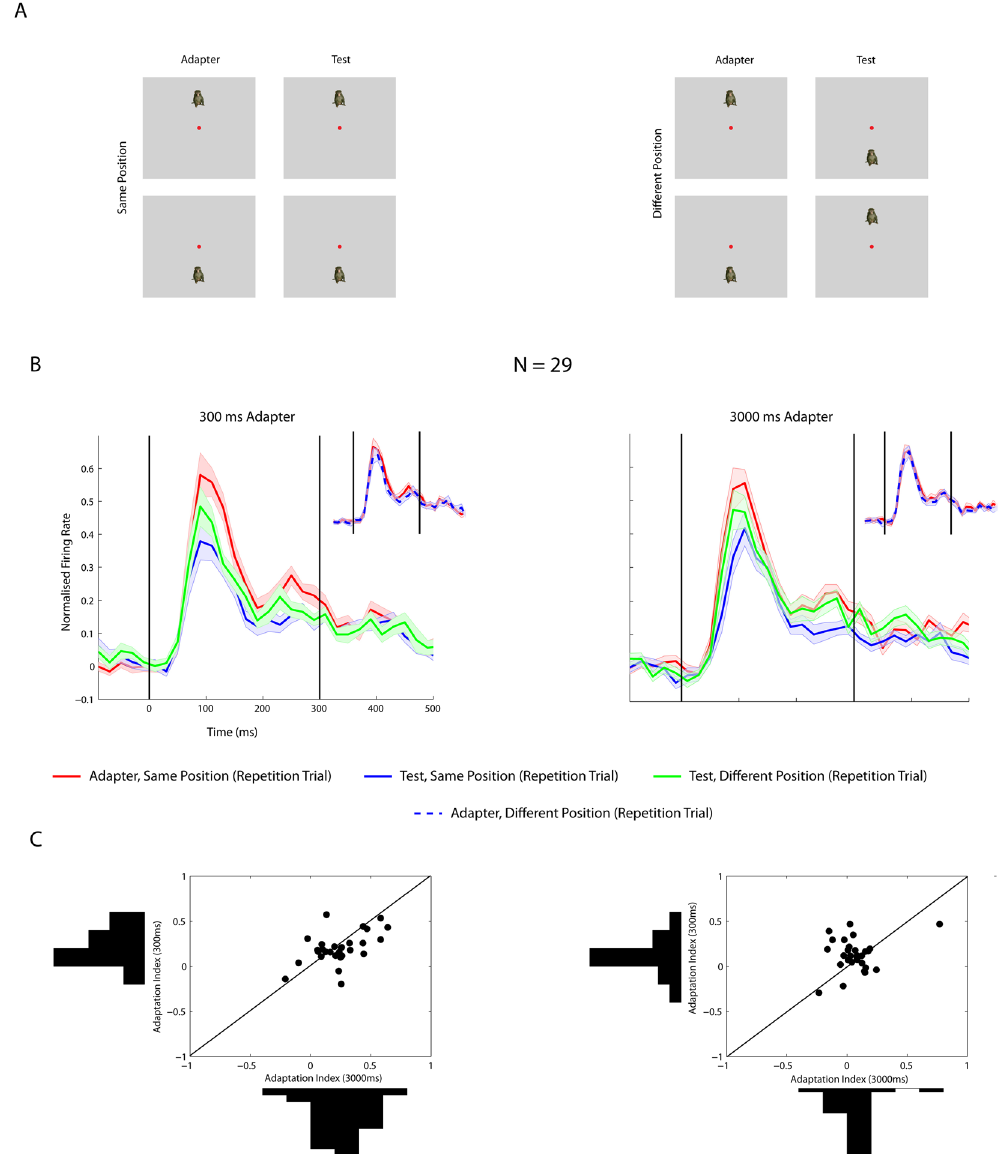
Figure 4. Repetition suppression when adapter and test stimuli were presented at the same or a different position. ( A ) Illustration of stimulus conditions. Adapter and test stimuli were presented at the same (left) or different positions above or below the fixation target along the vertical meridian. ( B ) Normalized firing rate of single IT units to adapter and test stimuli when the adapter and test stimuli were presented at the same position or at a different position during repetition trials. Left: adapter duration equaled 300 ms; right: adapter duration equaled 3000 ms. The insets compare the firing rates to the same adapter stimuli when followed by a test stimulus at the same or a different position. Same conventions as in Fig. 2. ( C ) Scatter plot and marginal distributions of adaptation contrast indices for 3000 ms (x-axis) and 300 ms (y axis) adapter durations. Left: Adapter and test presented at the same position; right: adapter and test presented at different positions. The diagonal (equal x and y values) is indicated by a black